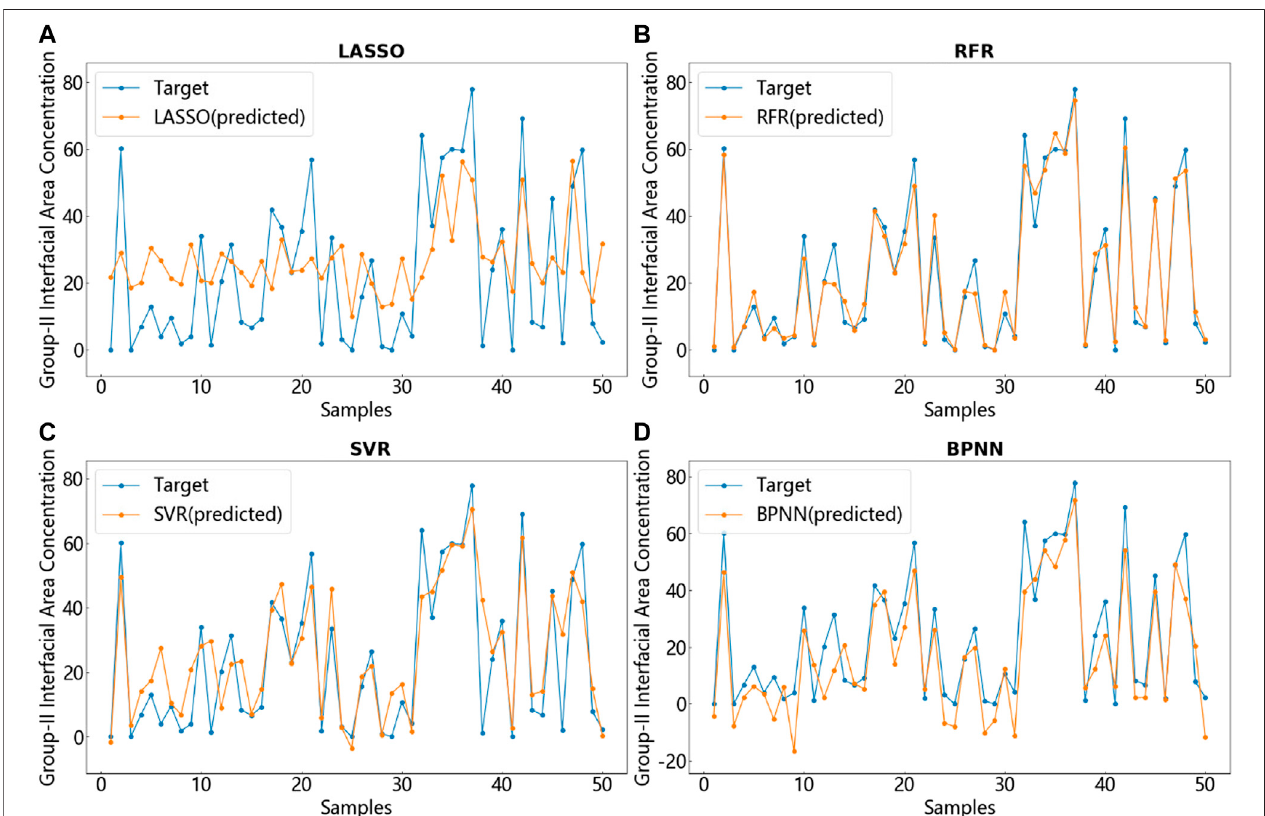
FIGURE8| Predictionofthegroup-II interfacialareaconcentrationusingfour modelsandcomparison withtarget values. (A) LASSO. (B) RFR. (C) SVR (D) BPNN.